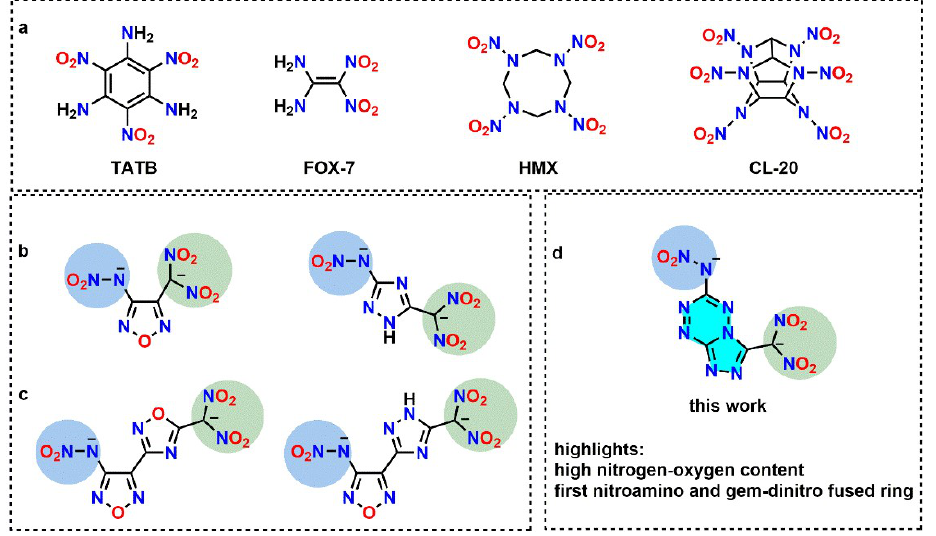
Figure 1. ( a ) Structures of TATB, FOX-7, HMX and CL-20. ( b ) Gem-dinitromethyl (green circle) and nitroamine groups (blue circle) substituted on a single ring. ( c ) Gem-dinitromethyl and nitroamine groups substituted on a linked ring. ( d ) Gem-dinitromethyl and nitroamine groups substituted on a fused ring (bright blue area).